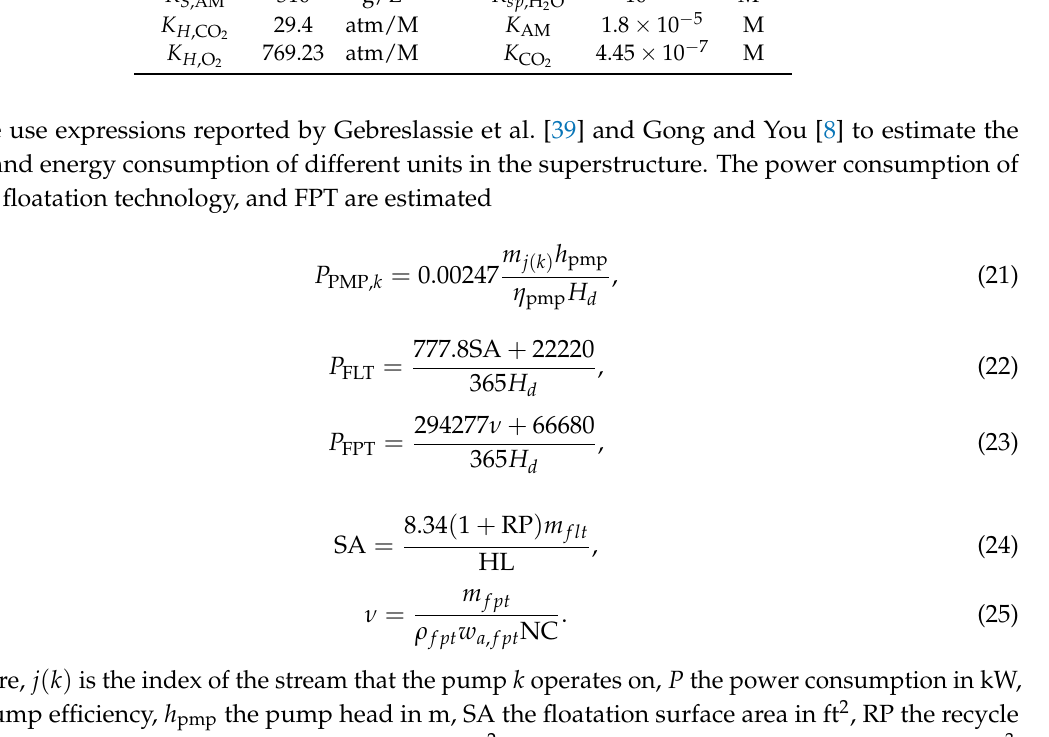
Table 2. Equilibrium constants of dissolution and dissociation equilibria Equations (11)–(20) at 25 ◦ C [38]. Constant Value Unit Constant Value K S